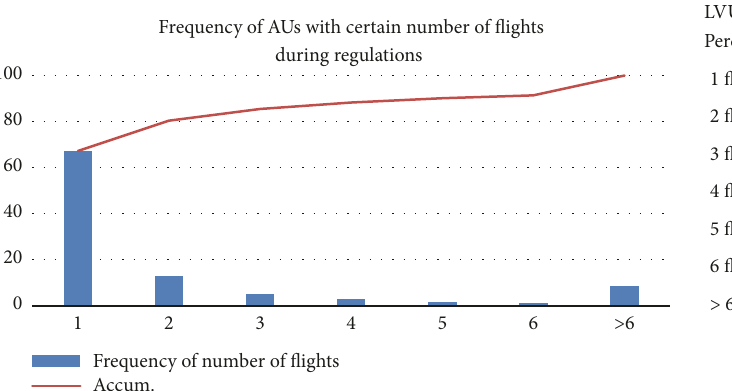
Figure 3: Statistically typical AU in terms of percentage of regulations/hotspots in which the AU has a certain number of flights.